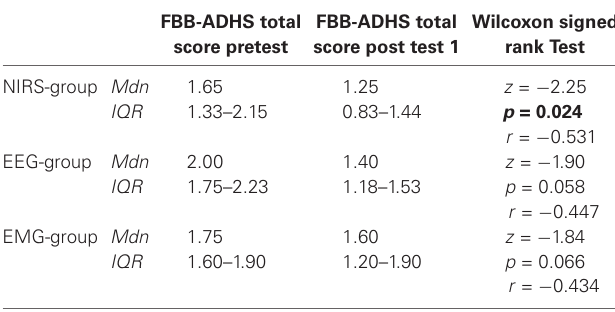
Table 5 | Parents’ ratings of the FBB-ADHS at pretest and post test 1 for the three groups with test statistics . FBB-ADHS total FBB-ADHS total Wilcoxon signed score pretest